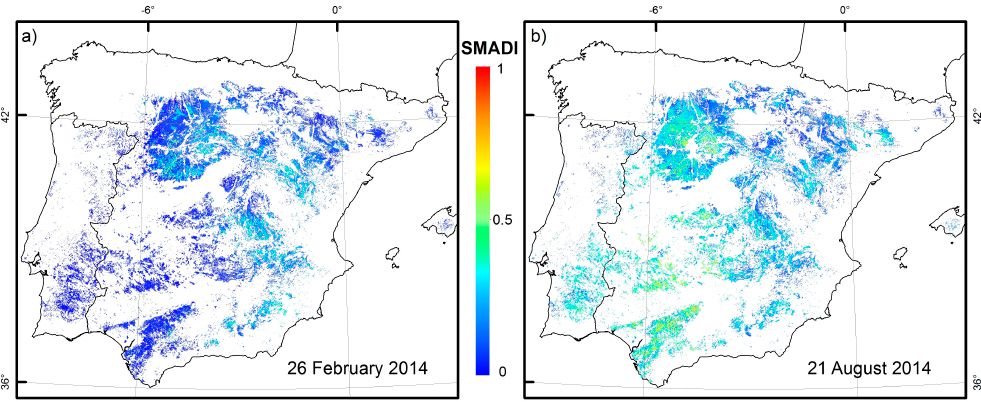
Figure 5. ( a ) SMADI maps (NDVI-LSTday version) for DoY = 57 (wet period) and ( b ) DoY = 233 (dry period).